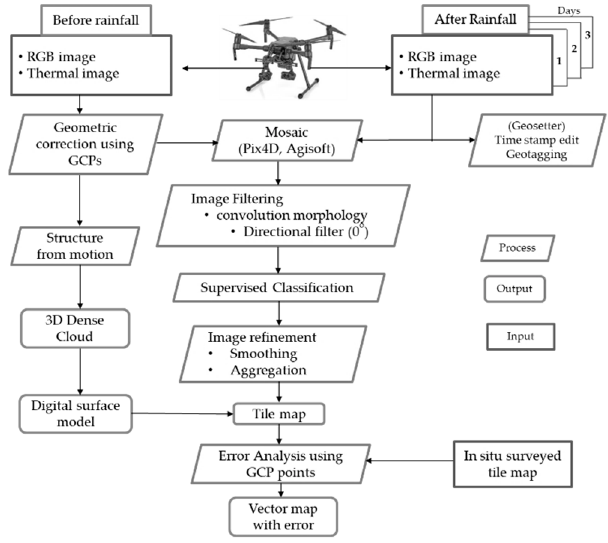
Figure 3. Flow chart showing steps of the methodology.